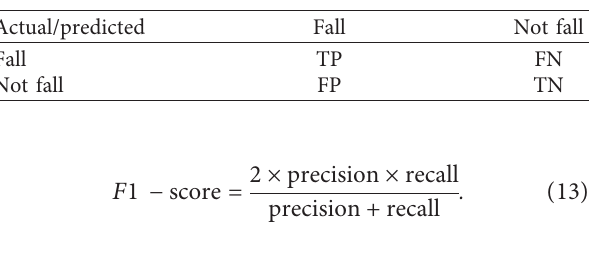
Table 4: Confusion matrix of downward